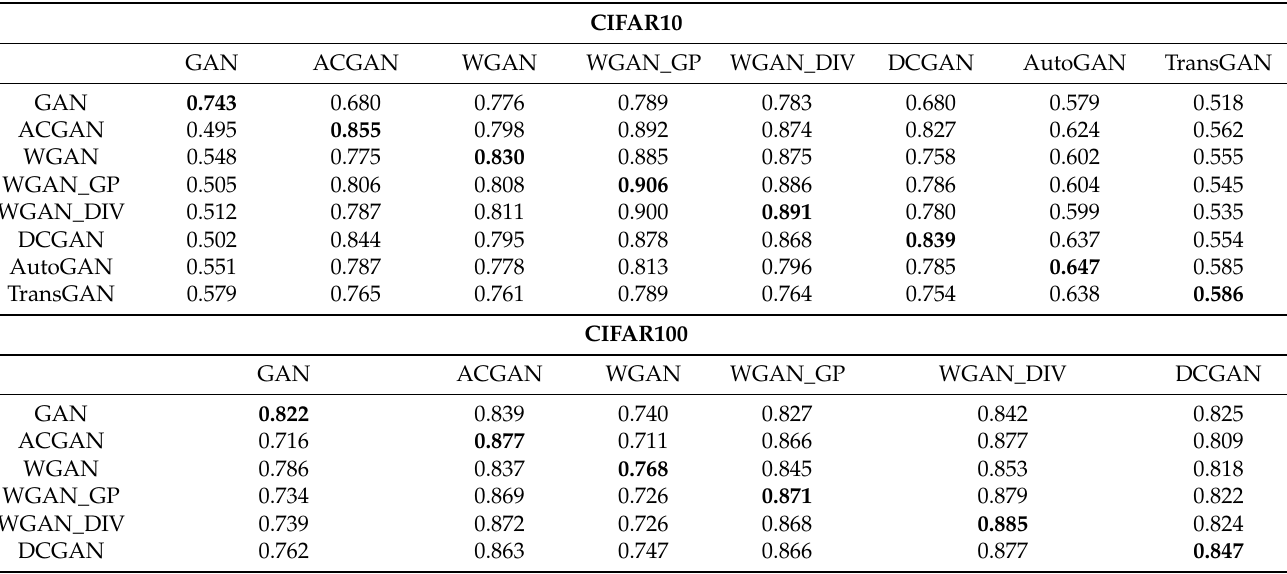
Table 2. The results of fake image detection (The vertical axis and the horizontal axis represent training and evaluation, respectively).